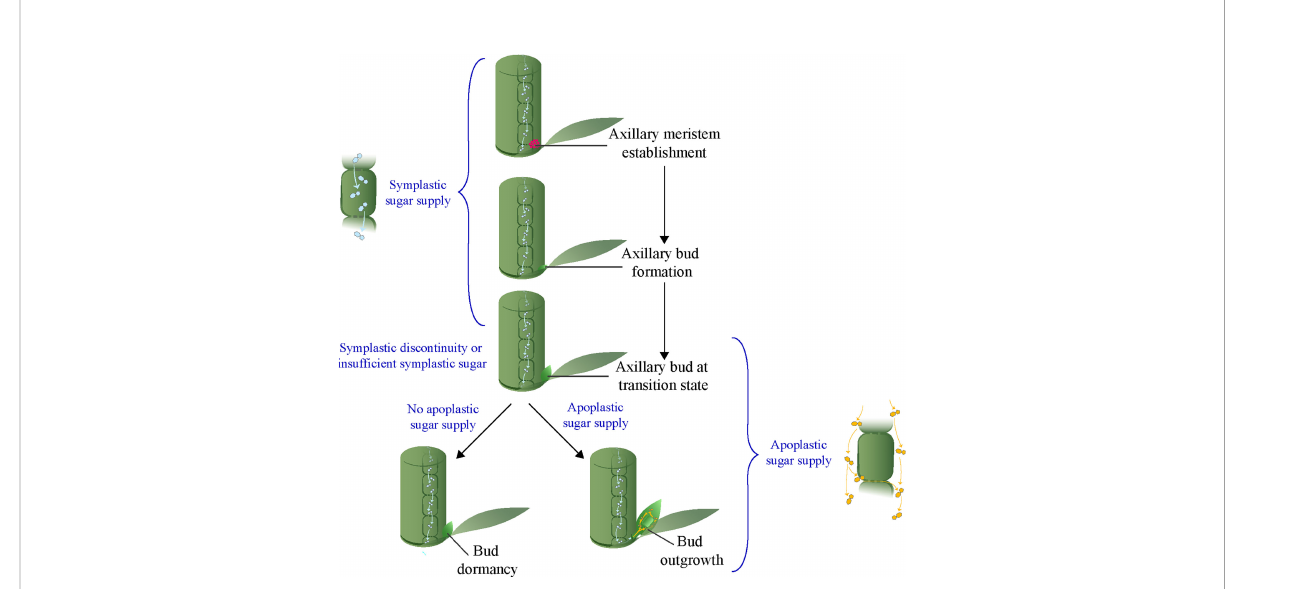
FIGURE 1 A model of axillary meristem fate depending on availability of apoplastic sugar at the transition